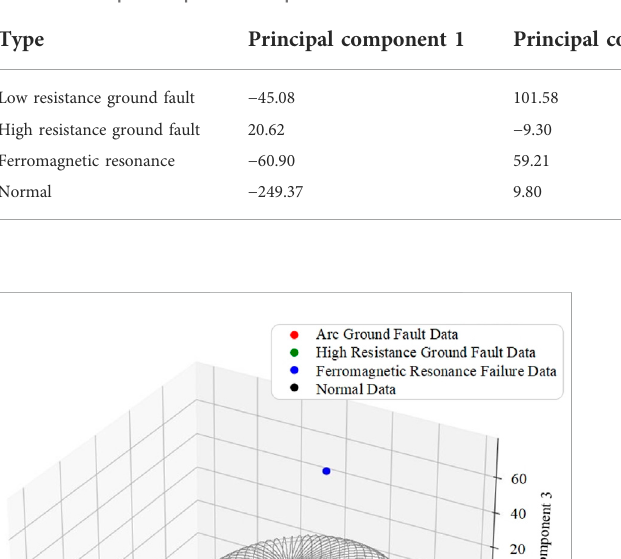
TABLE 7 Principal component components after dimension reduction for four types of samples.